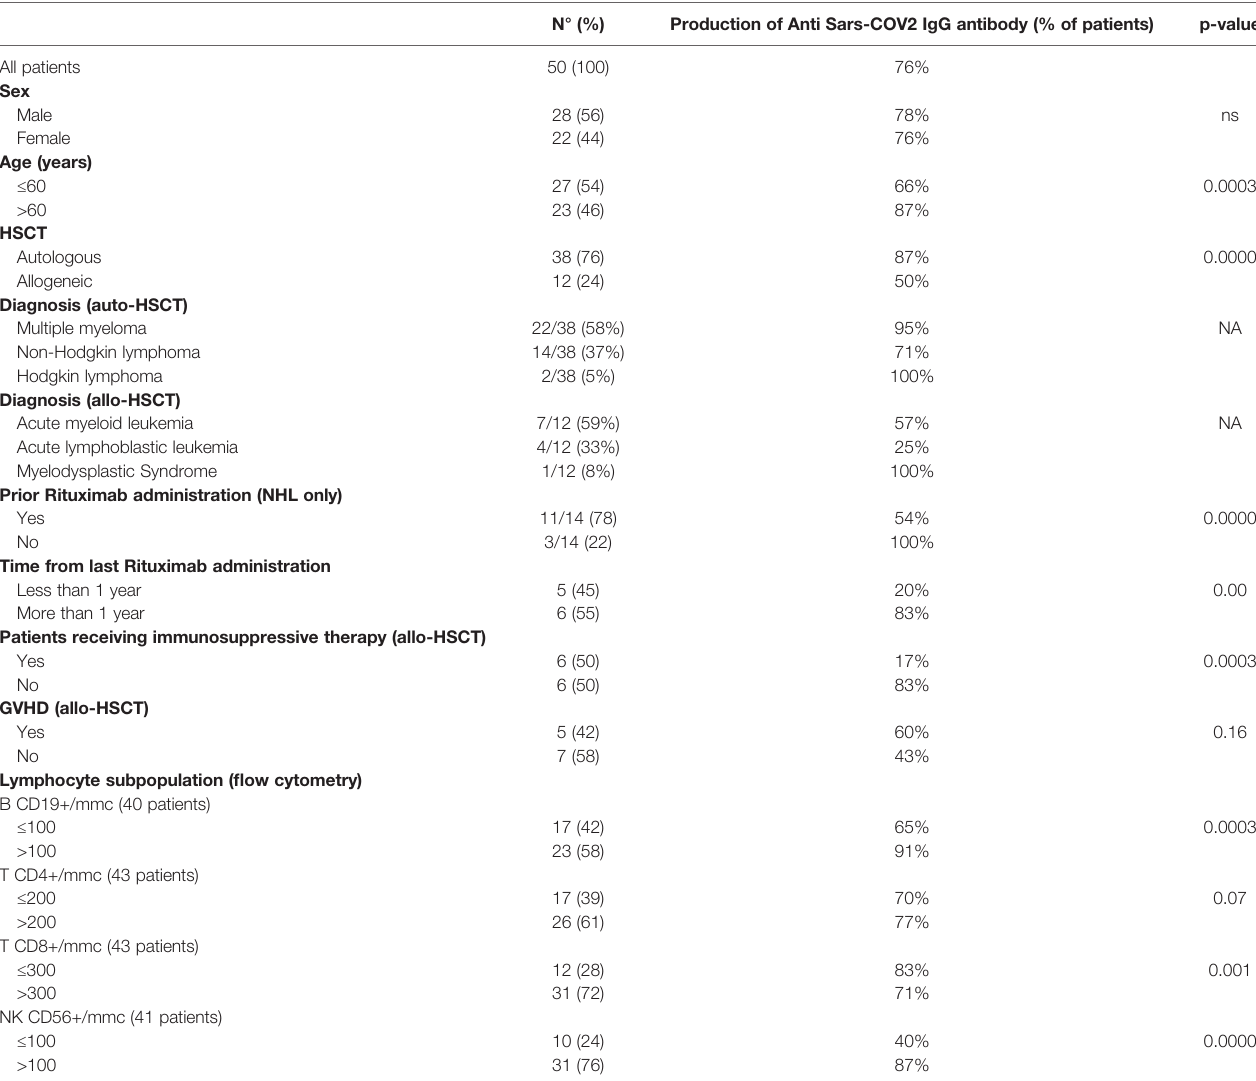
TABLE 1 | Patients characteristics and antibody response to Sars-COV2